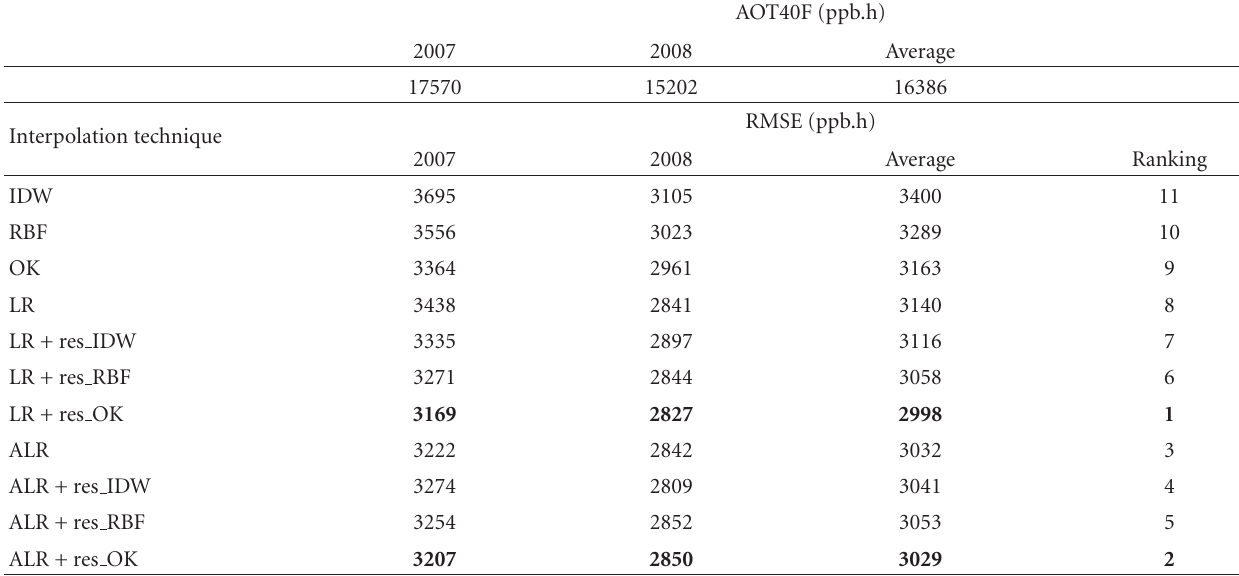
Table 3: RMSE values (ppb.h) from crossvalidation: comparison for di ff erent interpolation techniques for AOT40F, 2007-2008 vegetation